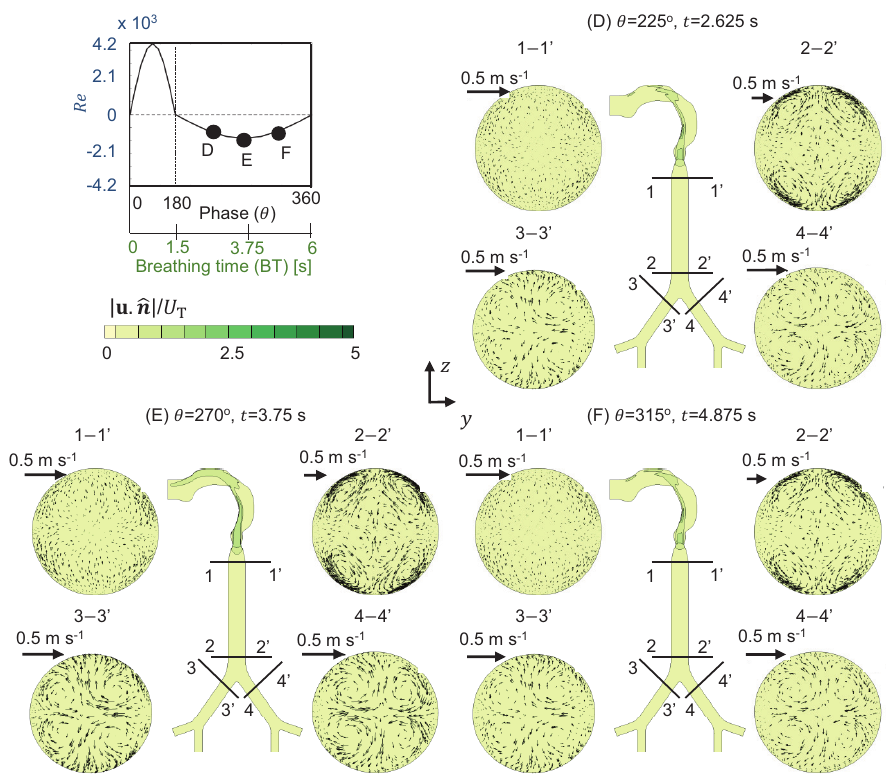
Figure 5. Contours of magnitude of a plane-normal velocity component (non-dimensionalized with mean flow speed in trachea, U T ) with superimposed in-plane velocity vectors for Planes 1–4 at various time-points during exhalation for Wo = 2.41 at IT/BT = 25%. D is at Phase θ = 225 ◦ (=25% ET), E is at Phase θ = 270 ◦ (=50% ET) and F is at Phase θ = 315 ◦ (=75%